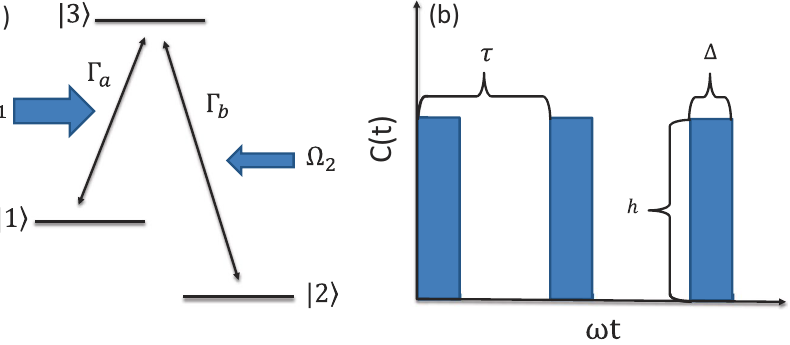
Figure 1. ( a ) A Λ -type three-level system driven by two fields with frequencies ω a and ω b , respectively. The field on the left (right), which drives the transition between |1 〉 (|2 〉 ) and |3 〉 , has a coupling strength Ω 1 (Ω 2 ) with this transition. The three-level system is also coupled to two bosonic baths, with the coupling strengths characterized by Γ and Γ . ( b ) Schematic illustration of the applied control pulses, where τ is the period of the a b pulses, Δ is the duration of each pulse, and h is the strength of the